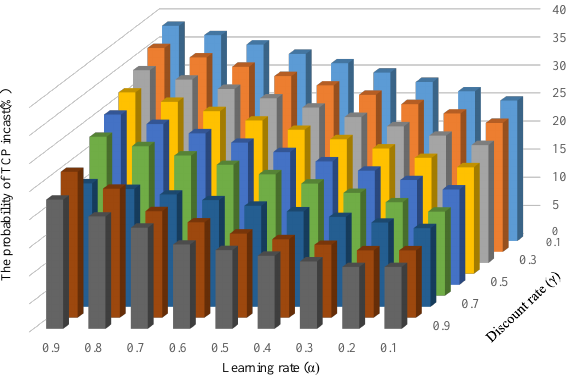
Figure 12. Probability of TCP incast occurrence against learning parameters: α , γ